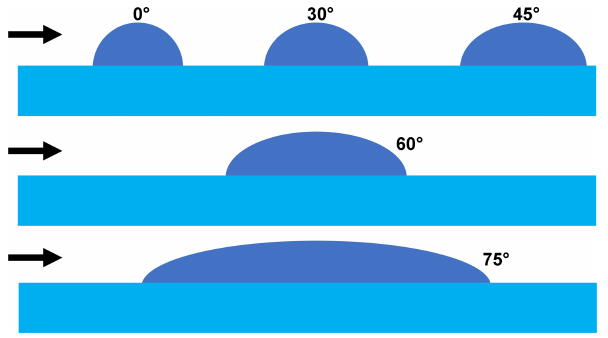
Figure A1. The streamlined shape of a wave (cylindrical half sphere) that experiences wind flowing over it from various angles θ .